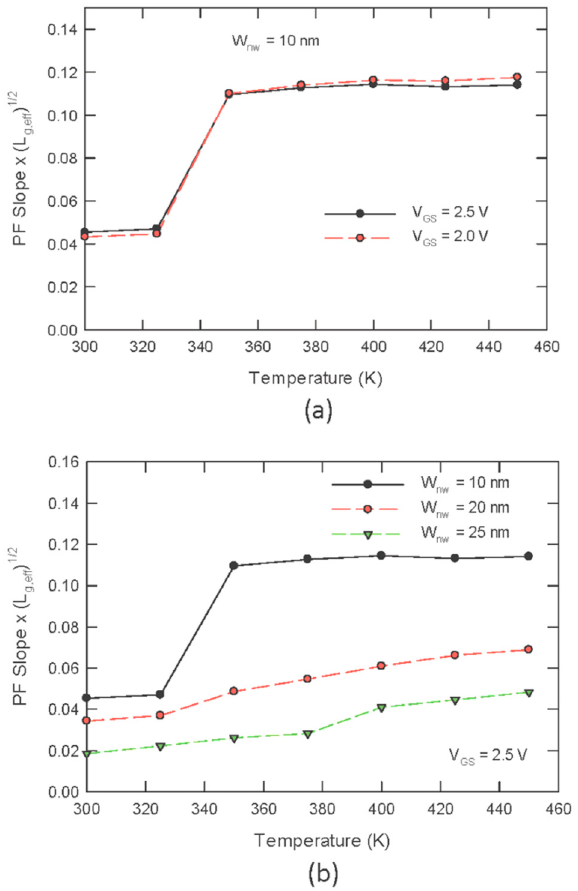
Figure 4. Plot of the PF slope as a function of temperature: ( a ) for narrow nanowires ( W NW = 10 nm), two piecewise regions are observed, and the PF slopes in both regions are fairly temperature indepen- dent; ( b ) wider nanowires show an increase in the slope as the temperature